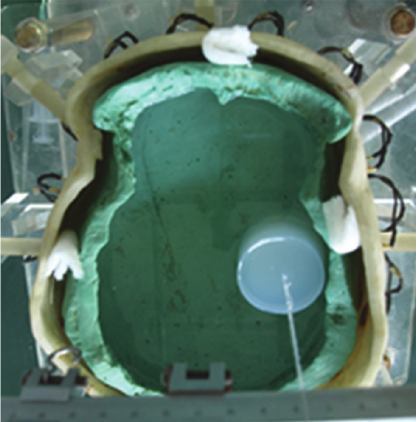
Figure 10: EIT data collection on the physical phantom with an agar cylinder. Figure 11: Location of the agar cylinders in the phantom: The initial radius of those cylinders was